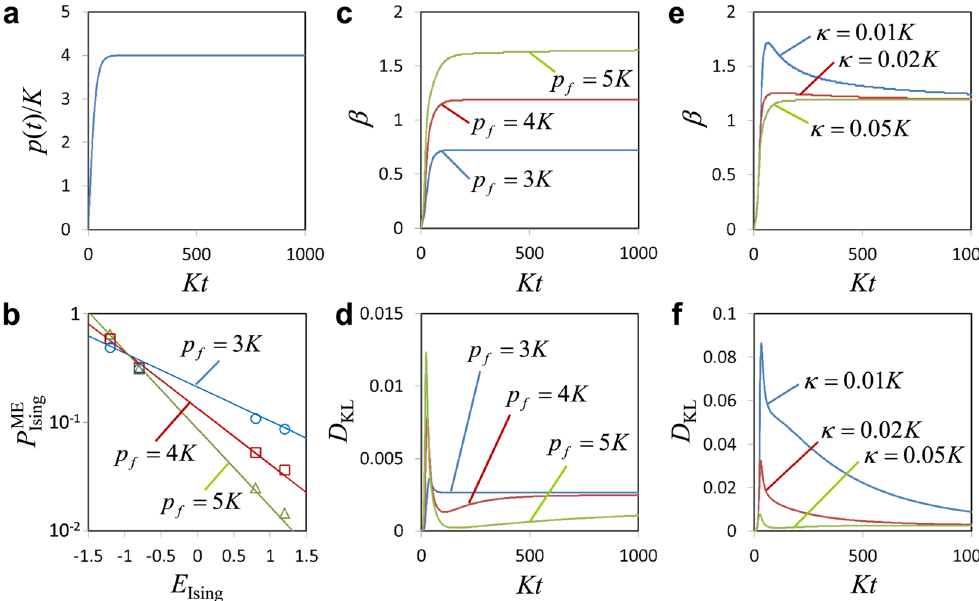
Figure 2. Dissipative QbM. The parameters of the two-spin Ising model are the same as that in Fig. 1. ( a ) Time- = ]. ( b ) Probability distributions of the spin configurations. dependent pump amplitude p t ( ) [Eq. (9) with p K 4 f Symbols show the spin configuration probabilities, P s ( ) IsingME , at the final time ( = − t K 1000 1 ), which are obtained with the numerical solution of the quantum master equation [Eq. (8)]. Circles, squares, and triangles correspond to = p K 3 , 4 K , and 5 K , respectively. The decay rate is set to κ = . K 0 05 . The lines show the f Boltzmann distribution fitting to the simulation results. ( c ) Inverse effective temperature β for the three values of p determined by fitting to the instantaneous probability distribution. ( d ) Kullbak-Leibler (KL) divergence f D KL minimized for the fitting in ( c ). ( e and f ) Time evolutions of β and D KL for various values of κ ( = p K 4 f